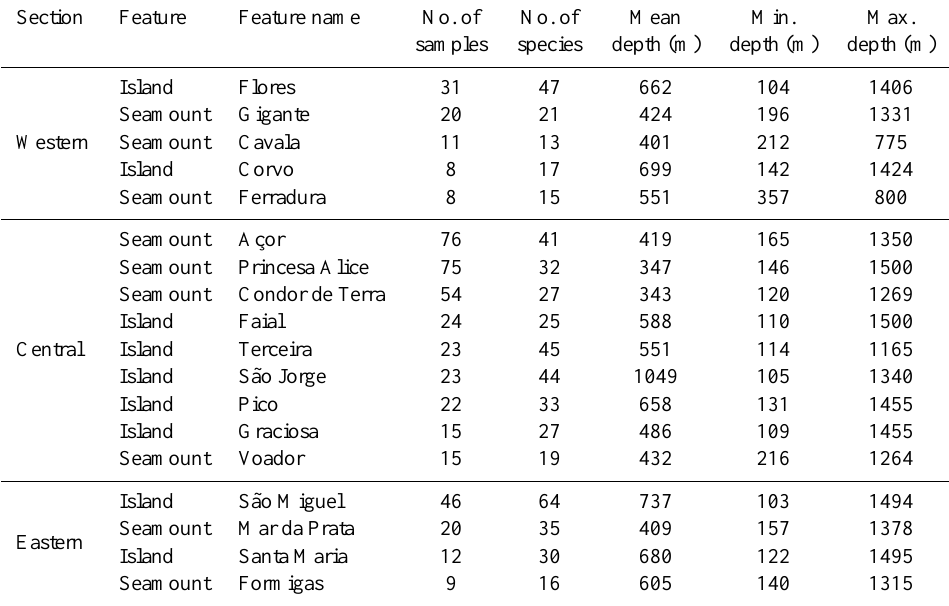
Table 3. List of features selected for biogeographic analysis of coral fauna. Numbers refer to the samples used (between 100–1500m) and do not include the total number of records available. Section